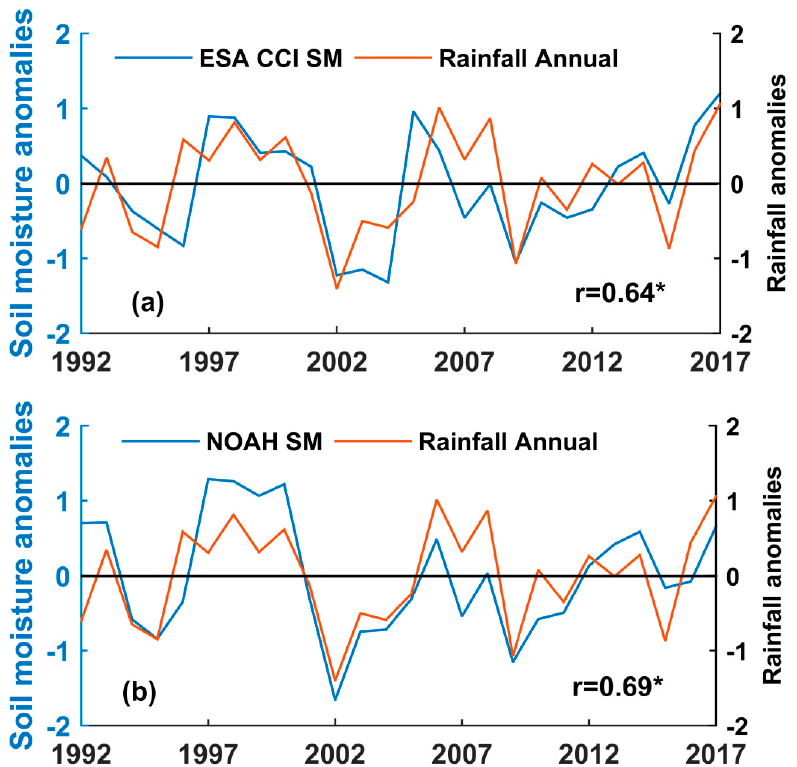
Figure 14. Time series of annual rainfall anomalies and ASM anomalies estimated using ( a ) ESA CCI and ( b ) FLDAS NOAH at 0 to 10cm depth averaged over the entire UBNB. The correlation coefficient (r) between the two datasets is also shown; the asterisk represents the value significant at p < 0.05.